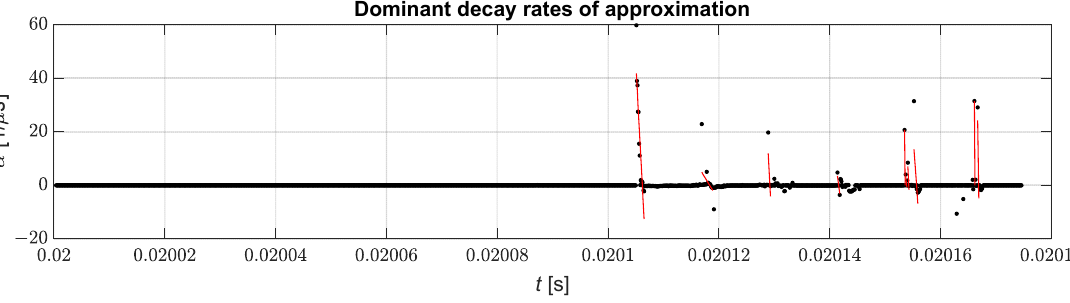
Figure 10. Selected decay rates used for pulse identification.